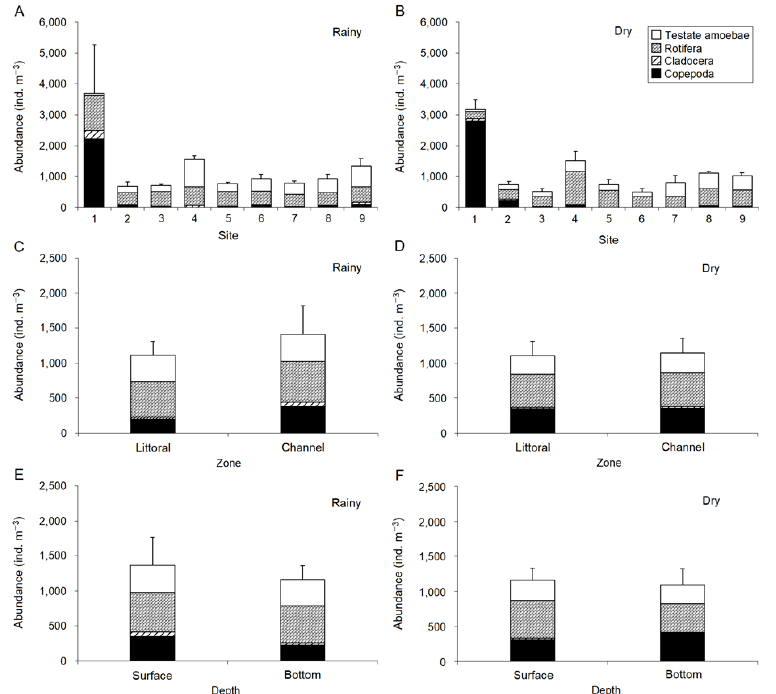
Figure 5. Zooplankton abundance of sites (A and B), zones (C and D) and depths (E and F) of the Aporé River, Paranaíba River basin, during the different hydrological seasons. Data were represented as mean ± standard error.